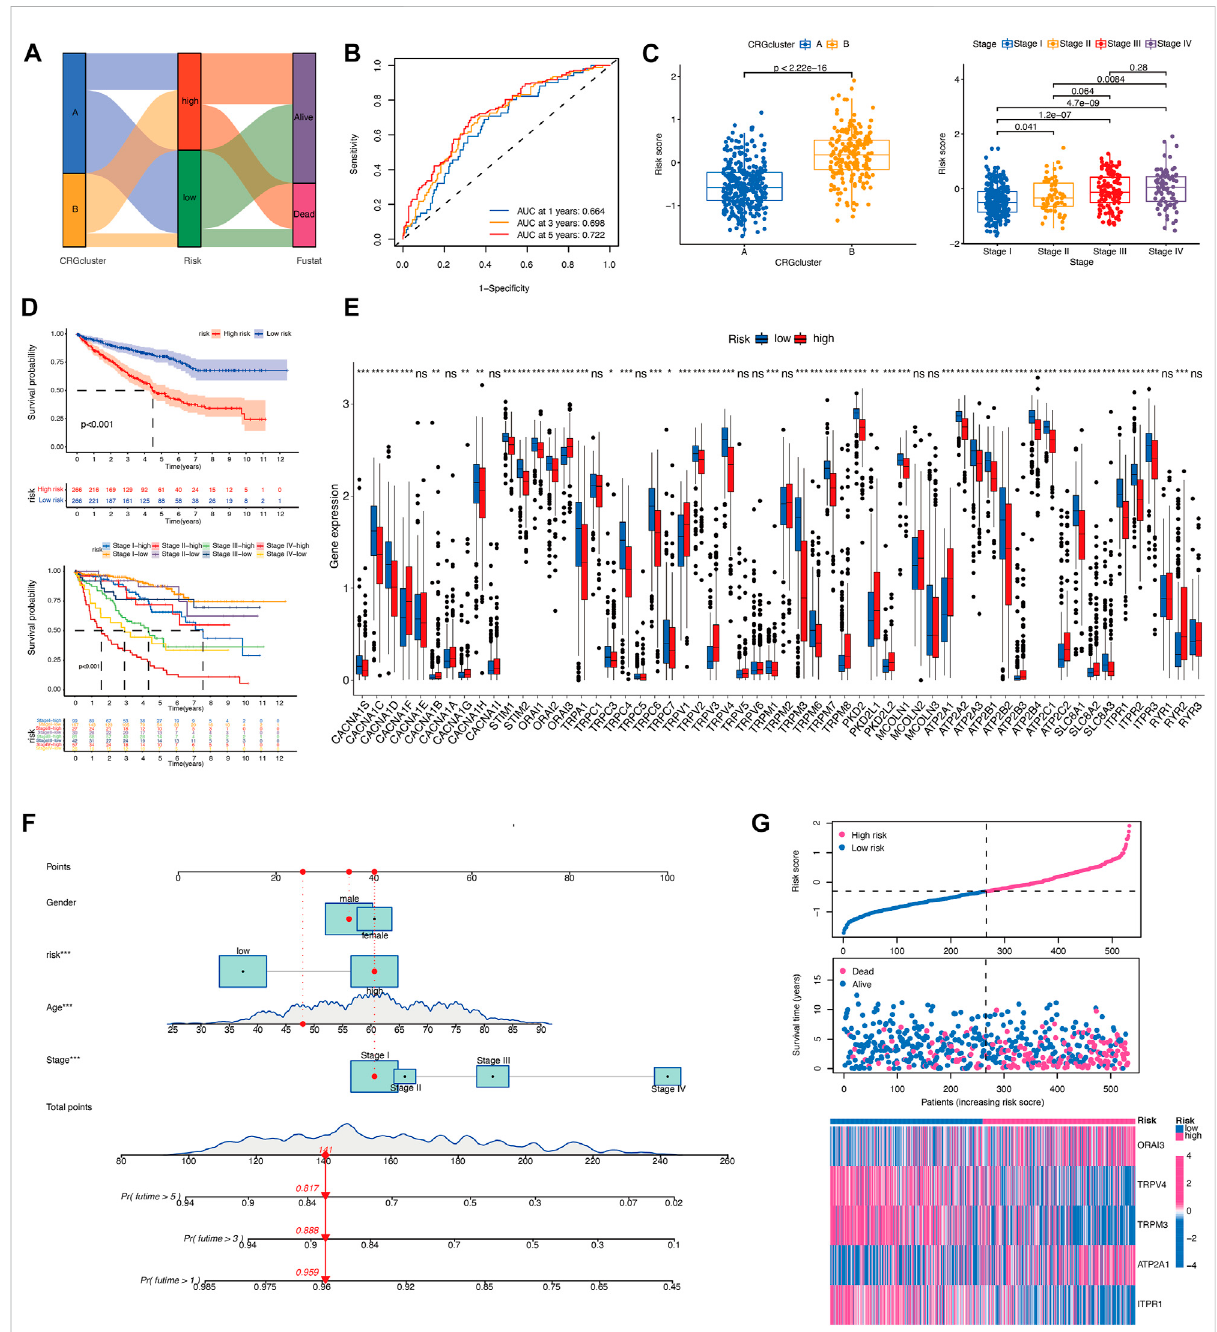
FIGURE 4 Development of the CRGs-related risk score in TCGA cohort. (A) The Sankey diagram demonstrates the distribution of patients with calcium clusters,CRGs-related riskscore, and patientstatus. (B) ROC curveshows thegood predictivevaluefor developmentof CRGs-related riskscore. (C) Risk score of KIRC patients in different calcium clusters and different disease stages. (D) Kaplan – Meier curves showed the overall survival between CRGs-related risk subtypes in TCGA cohort. (E) CRGs expression between CRGs-related risk subtypes. (F) The nomogram is created for calculating the total score of KIRC patients based on the values of each variable. (G) Five prognostic-related genes expression in order of increasing risk